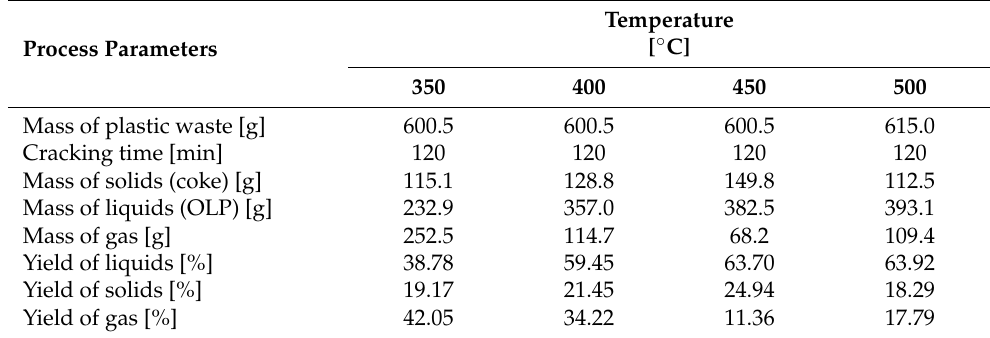
Table 4. Mass balance and yields of reaction products of thermal cracking of WEEE plastic over the temperature range of 350–500 ◦